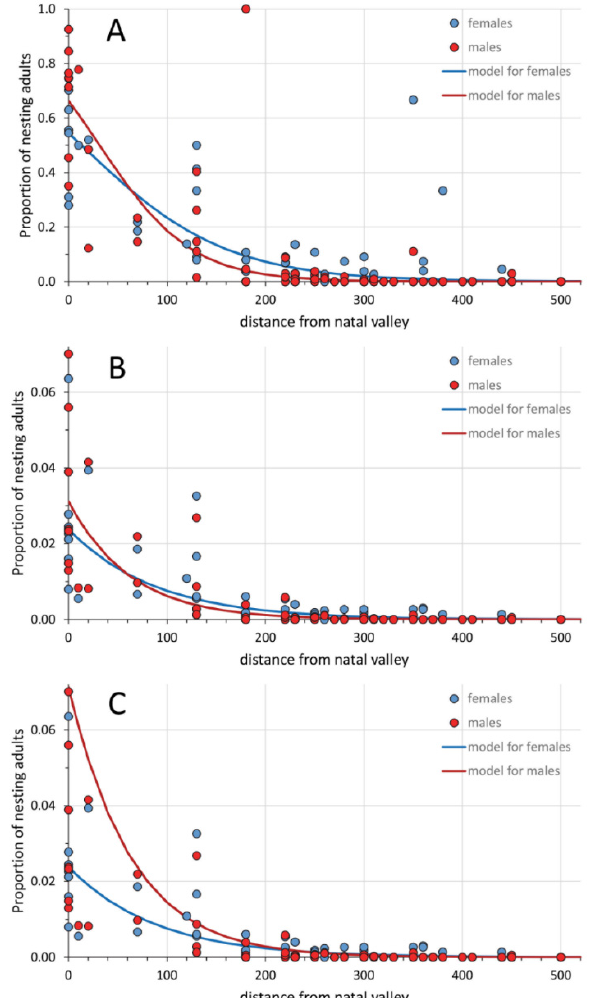
Figure 2. Functional response of banded individuals to distance (in meters) to their natal valley for the three GLM binomial models ( A ) Model I: Binomial ANOVA for recaptured/total recaptured. ( B ) Model II: Binomial ANOVA for recaptured/total banded (assuming sex ratios as in recaptured). ( C ) Model III: Binomial ANOVA for recaptured/total banded (assuming sex ratios to be 50:50%). See section Methods for more details.